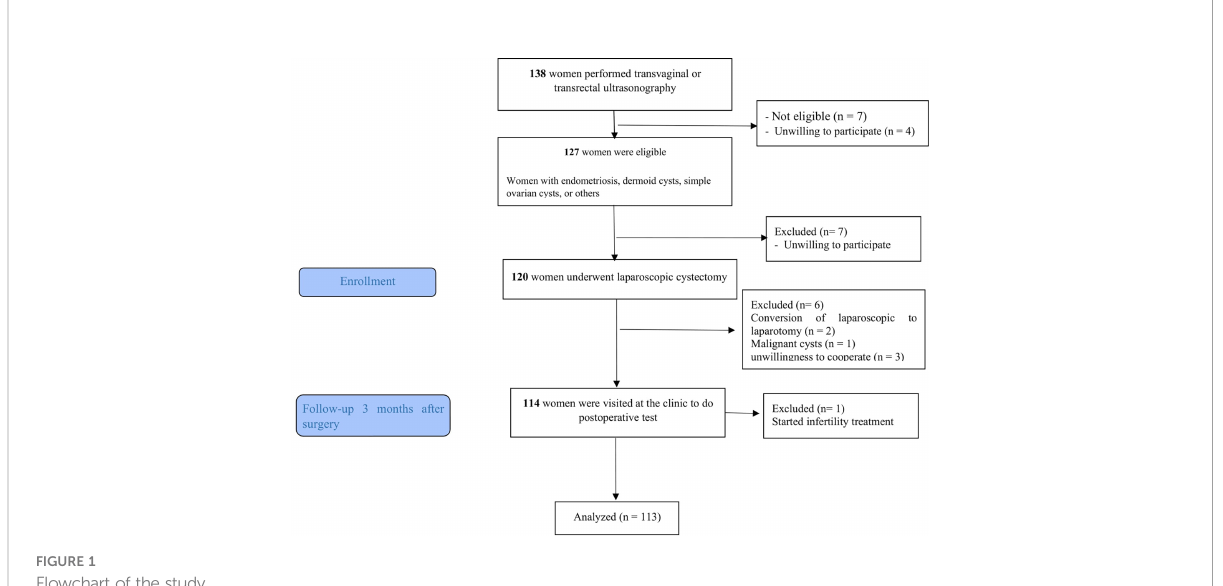
FIGURE 1 Flowchart of the